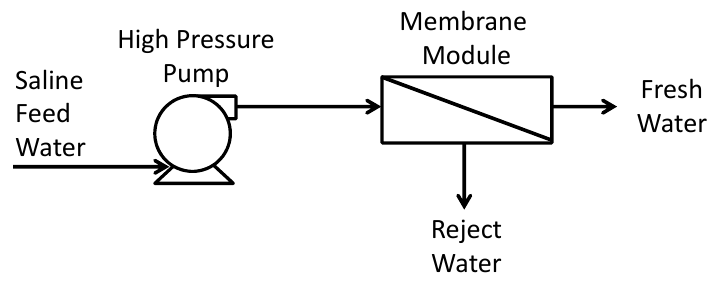
Figure 4. Single-stage system.